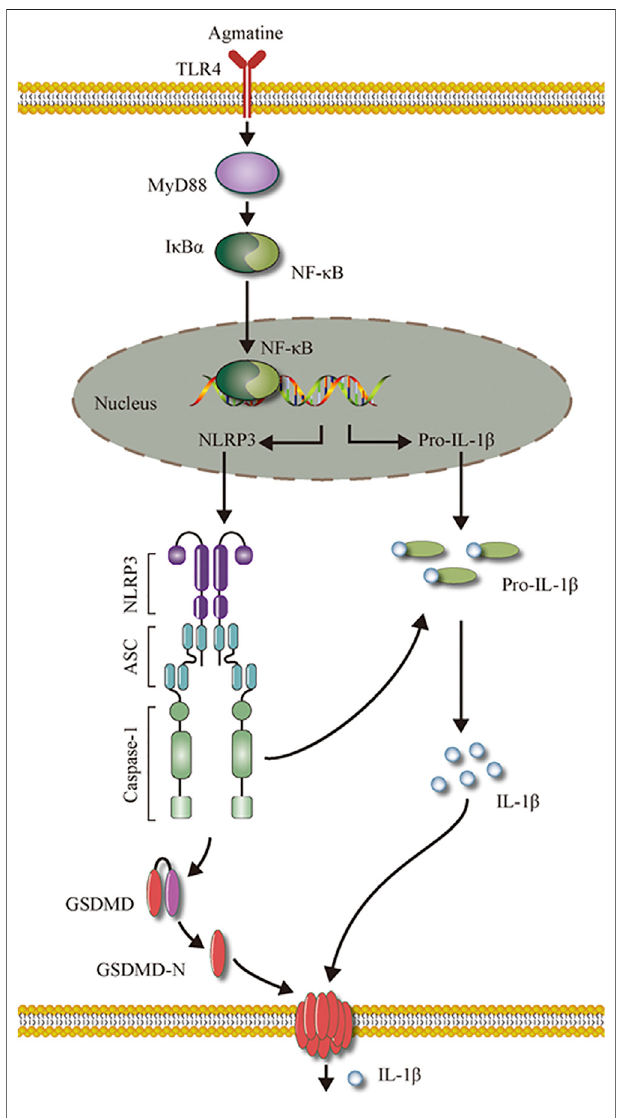
FIGURE 9 | The schematic model of the role of agmatine on pyroptosis in seizures.